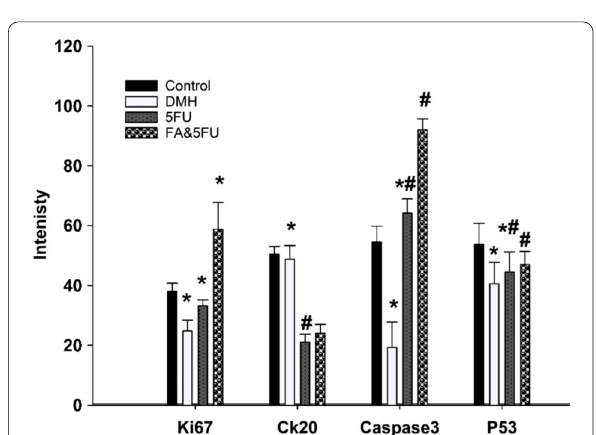
Fig. 9 P53 gene expression among the study groups. Values are mean SD at p 0.05. *, significance against control. #, significance ± ≤ against DMH